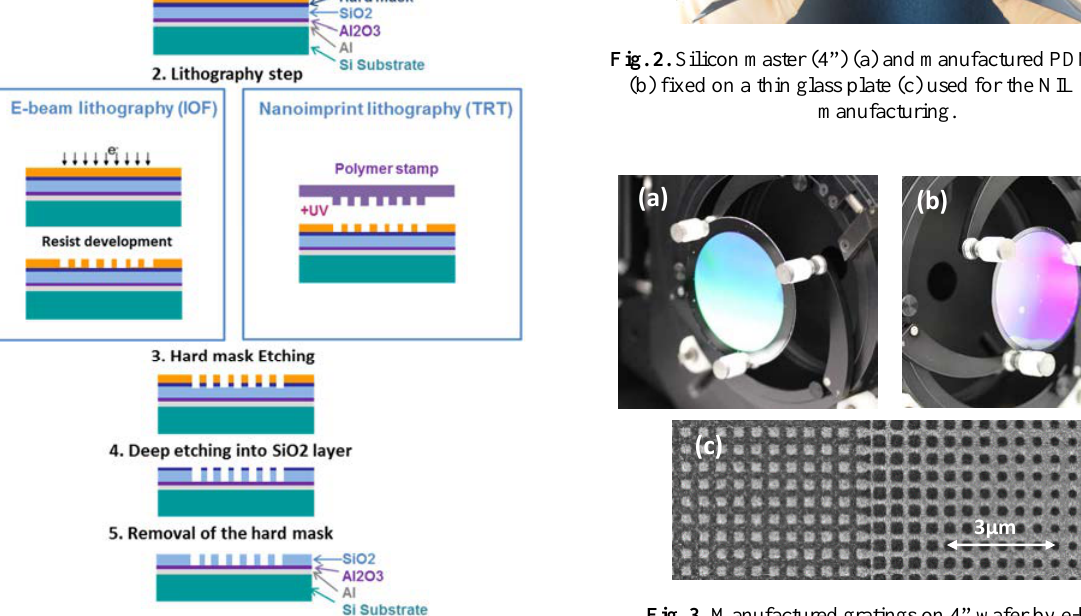
Fig. 3. Manufactured gratings on 4” wafer by e-beam lithography (a) and on 3” wafer by NIL (b). (c) SEM top view of few subwavelength structures of the NIL